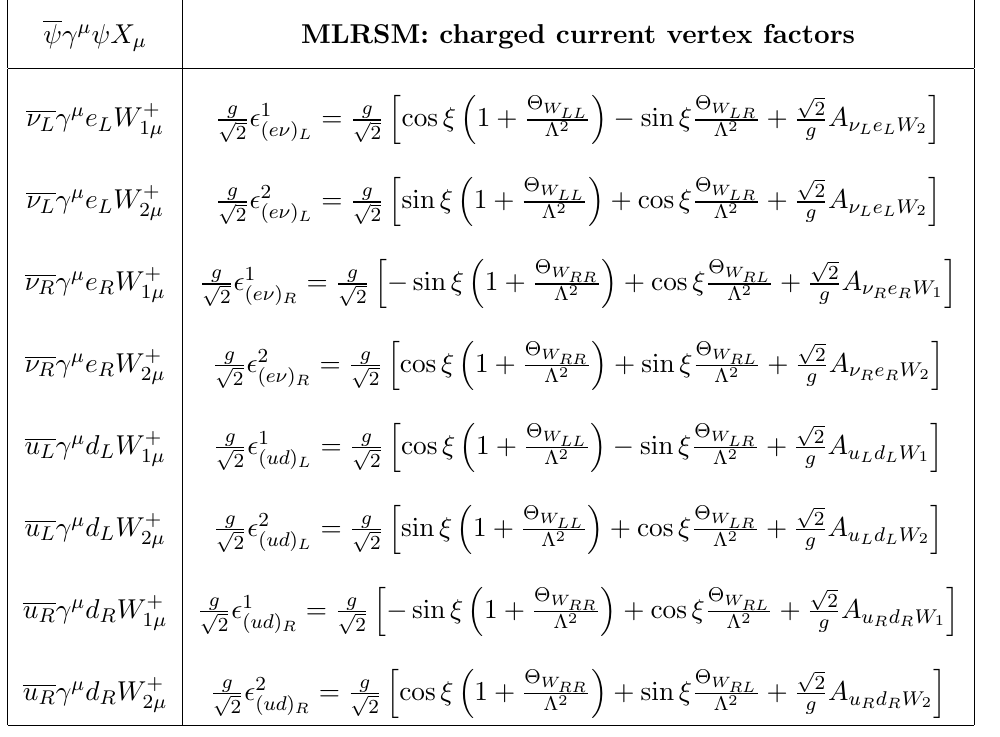
Table 29. MLRSM: coupling of charged gauge boson and fermions. Here, ~ e = e Hermitian conjugate of these vertices are not separately mentioned. The detailed structures of A ’s are depicted in table